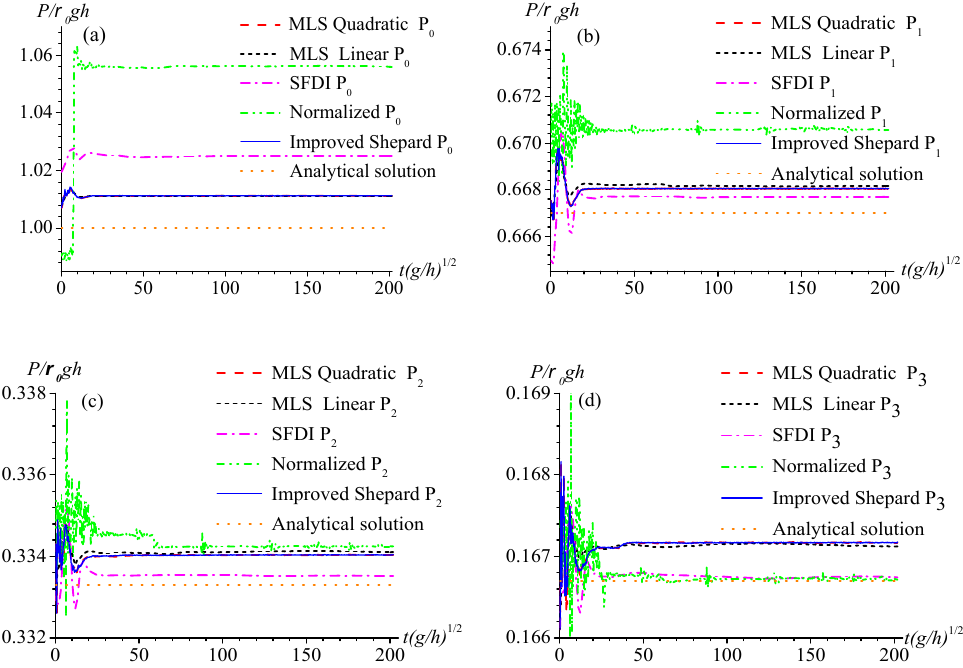
Figure 3. Time history comparison of static water pressure. Comparison between the MLS, SFDI, normalized, and improved Shepard methods at ( a ) P 0 , ( b ) P 1 , ( c ) P 2 , and ( d ) P 3 .